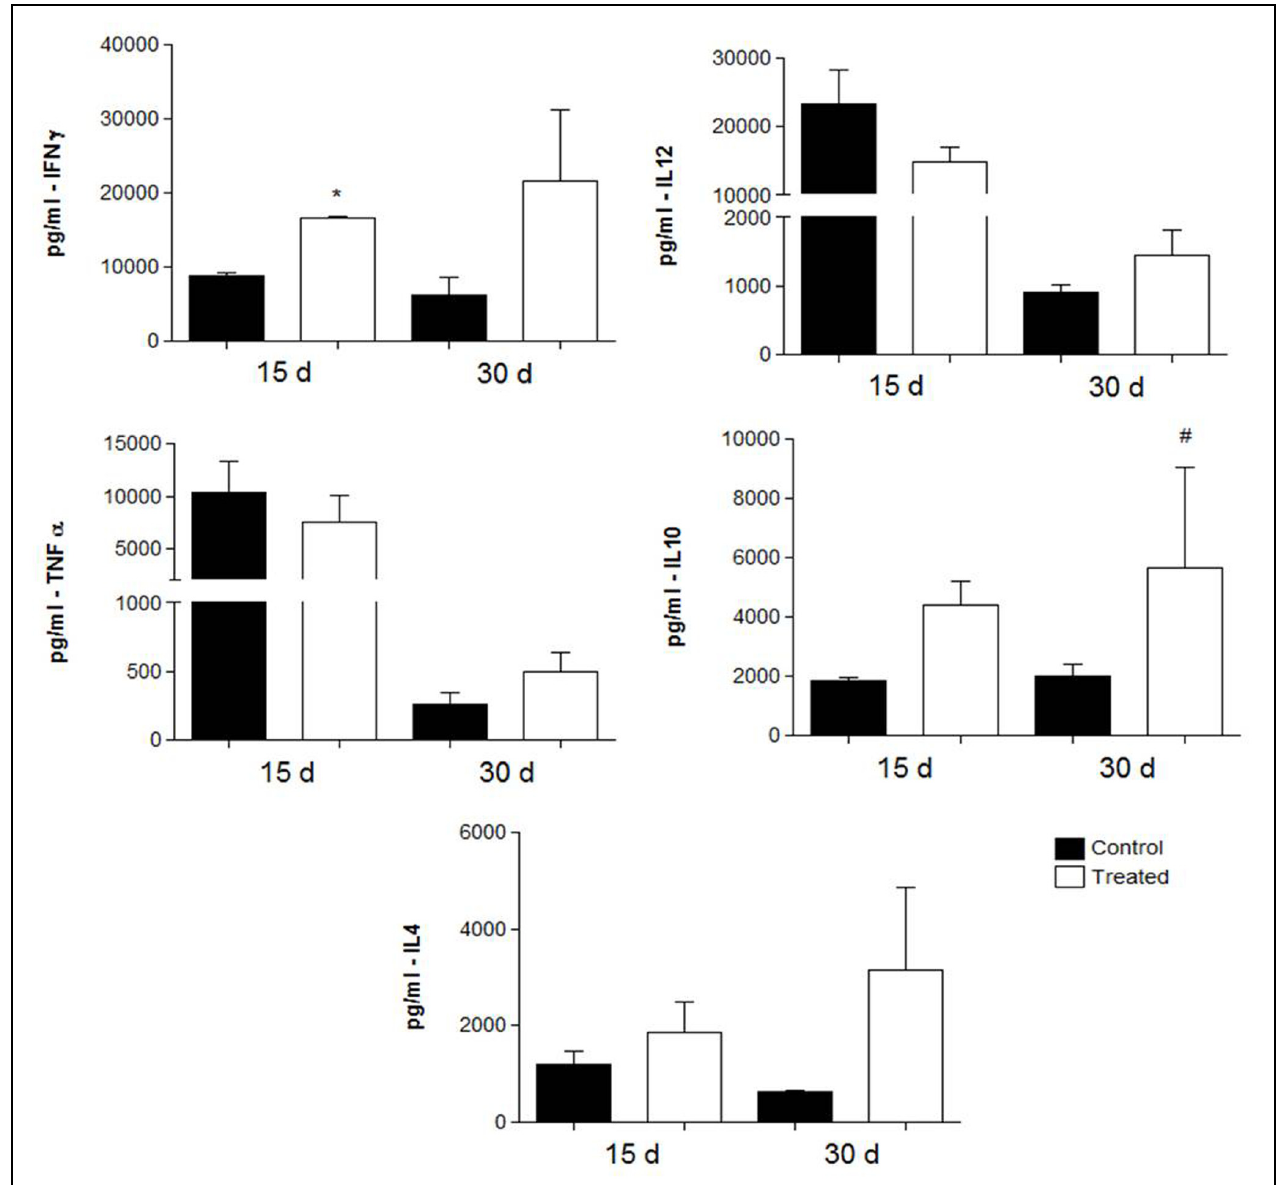
FIGURE 5 | Cytokine levels in the lungs obtained from BALB/c mice that received either 1 mg of polyclonal antibodies against acidic glycolipids or 1 mg anti-BSA polyclonal antibodies (control) 24 h before infection with Pb18 and sacrificed 15 or 30 days post-infection (prophylactic protocol). ∗ p < 0.05, # p < 0.05 (student’s t